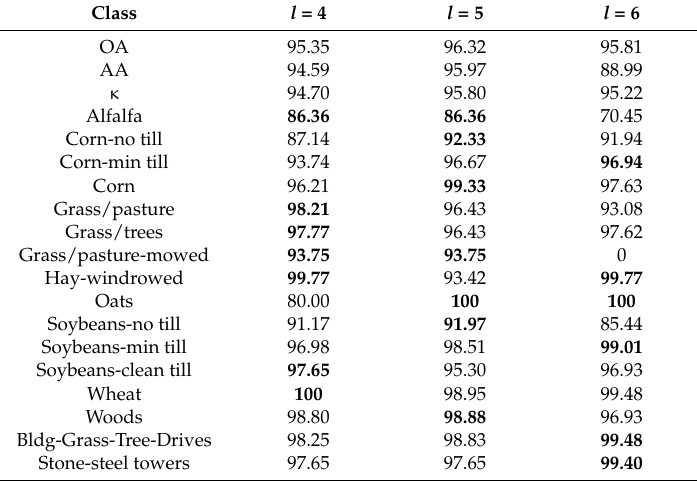
Table 5. The GAs and CAs (percent) produced by our method using different values of l from 4 to 6 for the Indian Pines image. The highest accuracies are indicated in bold in each